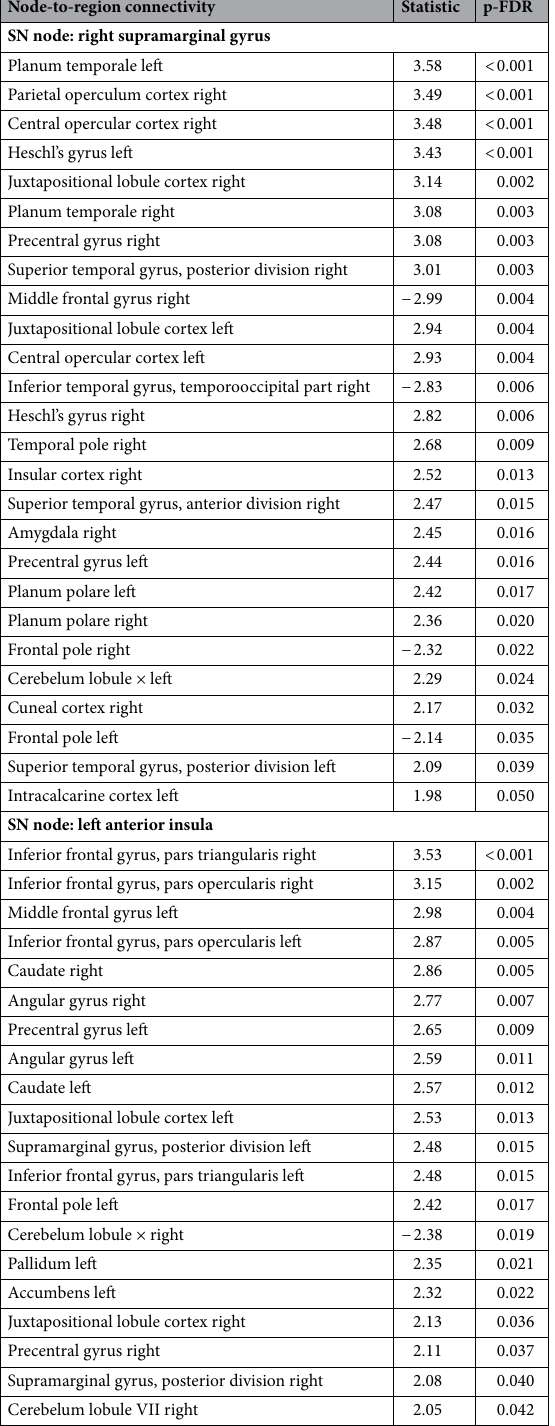
Table 3. Node-to-region connectivity differences between concussed and control participants using network based